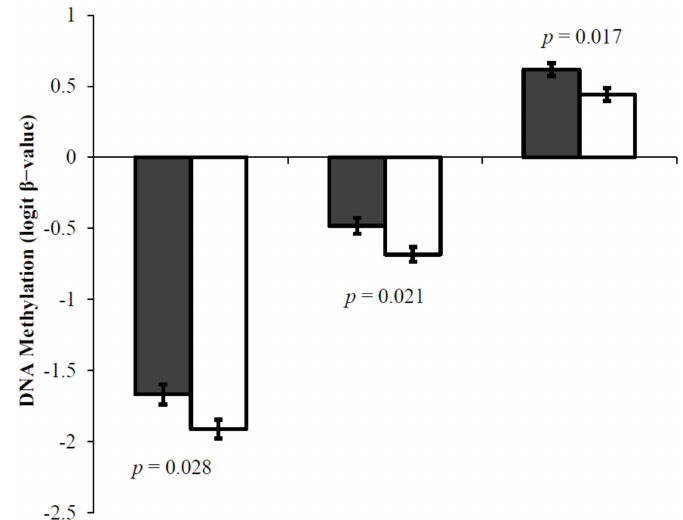
Figure 3. HTR2A DNA methylation in patients with schizophrenia compared to controls for three CpG sites, cg5, cg7 and cg10. ANOVA showing mean DNA methylation level and standard error in patients with schizophrenia (solid dark-grey bar) and controls (solid white bar).